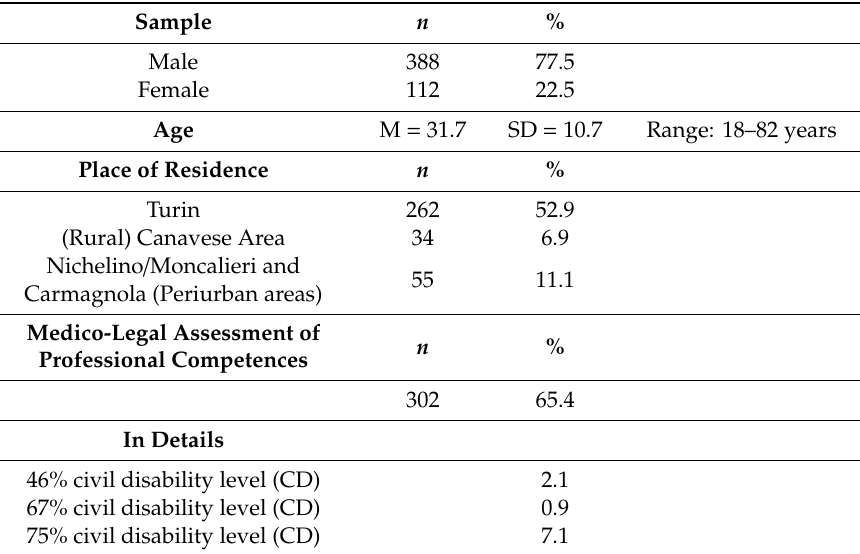
Table 1. Description of the participants.